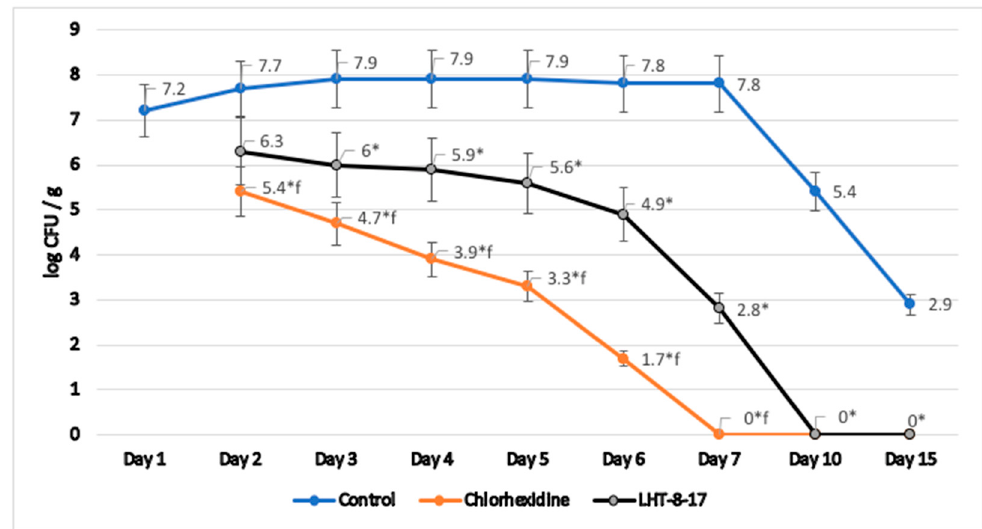
Figure 10. Dynamic S. aureus contamination of experimental diabetic wound tissues, T2D db / db mice; mean ± SD; * p < 0.05 compared with the control, f p < 0.05 compared with chlorhexidine (independent t -test with Bonferroni’s adjustment), n = 3 at each time point.